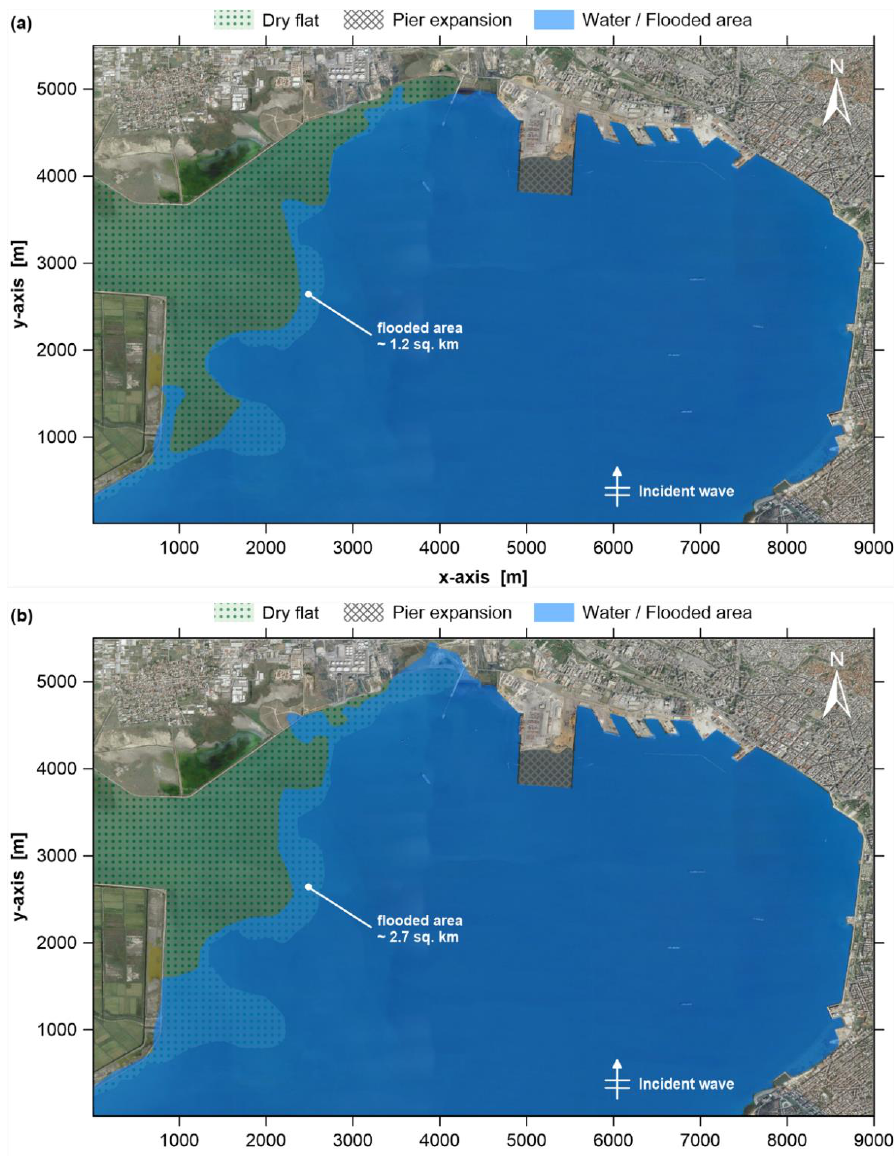
Figure 8. Model results indicating the flooded area for scenarios: ( a ) LS1 and ( b ) LS2 (background image from [68]; privately